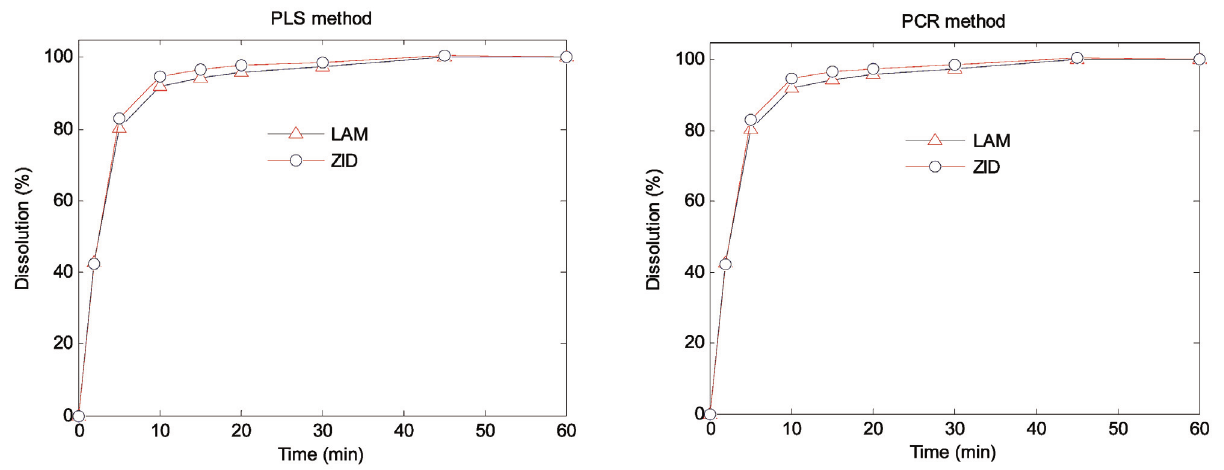
Figure 7. Dissolution profiles of the ZID and LAM drugs by applying the proposed PLS (a) and PCR (b) methods with four